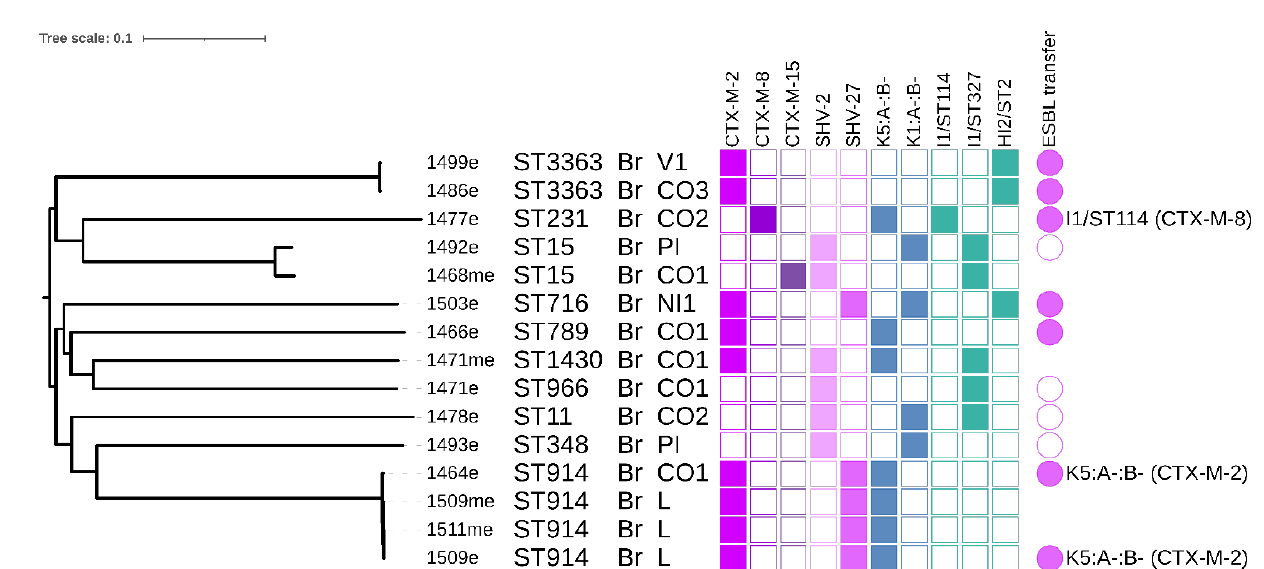
Figure 3. Phylogeny of selected K. pneumoniae isolates from Paraguayan farms. The columns isolate name (consist of the sample number and “me” for selection using meropenem and “e” for selection using cefotaxime); sequence type, hatchery (Br–Brazil); farm (label consist of the village name and farm number: Villeta: V1; Nueva Italia: NI1; Colonel Oviedo CO1–3; Piribebuy: PI; Luque: L). The color squares indicate presence of selected antibiotic resistance genes (purple-pink), F plasmid replicons (blue) and other plasmids (turquoise). The color circles indicate transferability of ESBL genes (pink) in conjugation experiments, full circles mean the conjugation was successful including confirmation of presence of respective genes by PCR, empty circles represent unsuccessful conjugation. For the single-plasmid fully typed transconjugants, the information which plasmid replicon carries the respective gene is presented next to the circle.